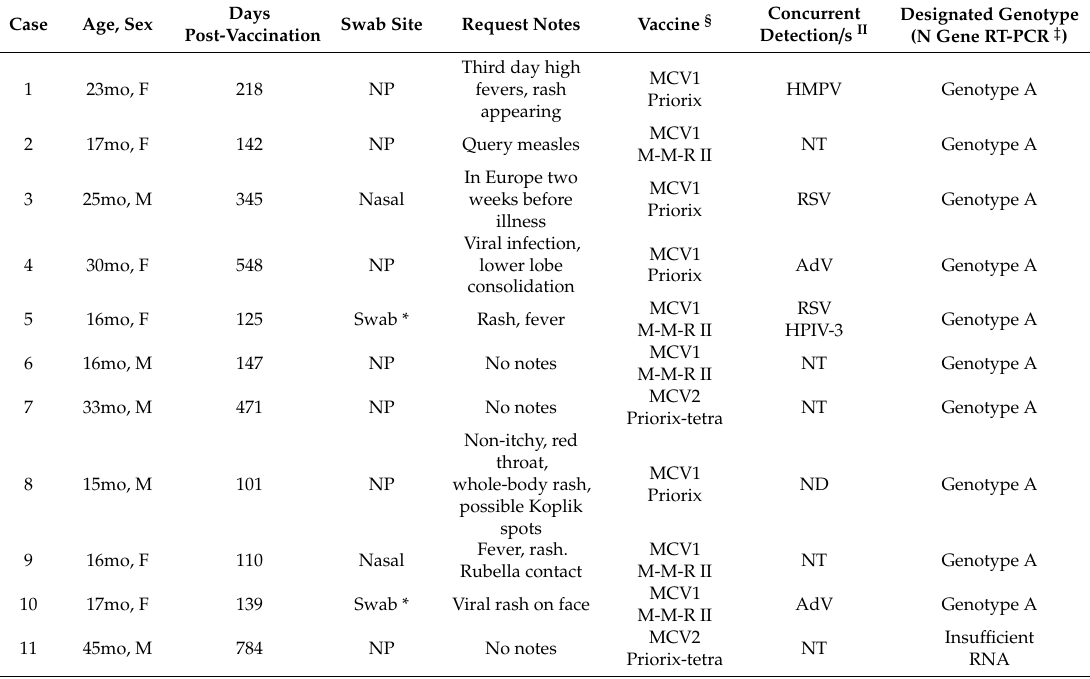
Table 1. Details of cases with measles vaccine virus detection more than 100 days